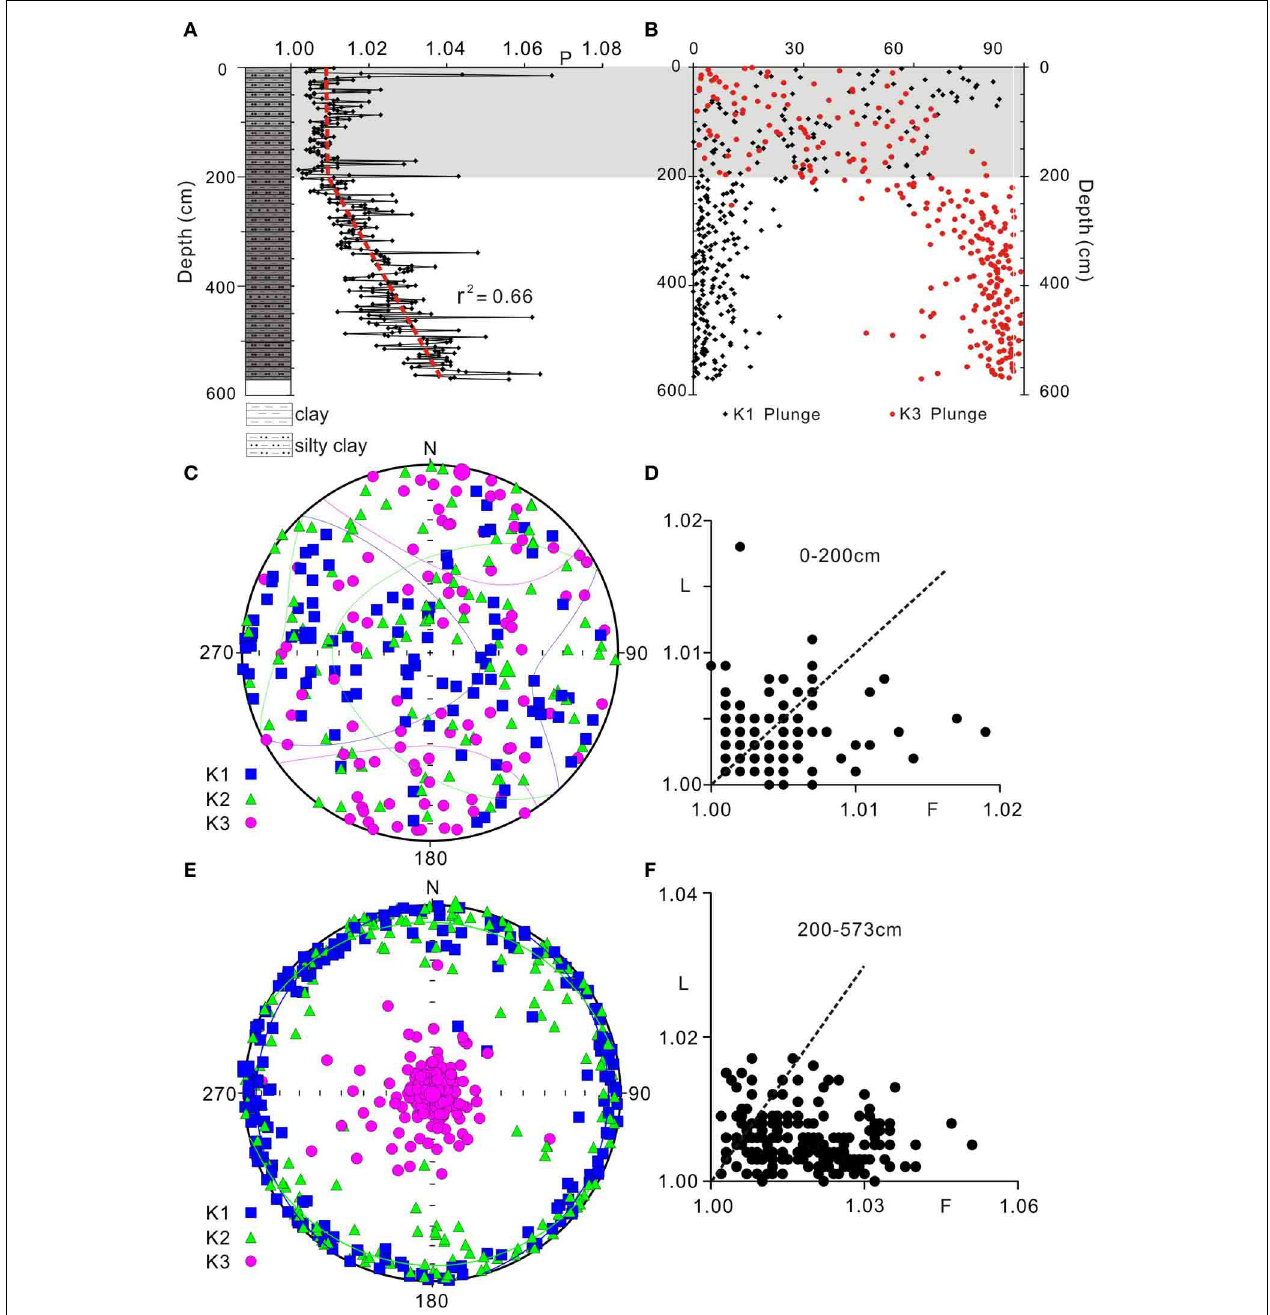
FIGURE 3 | Down-core changes in composition and AMS of Core GHE27L. The composition (A) and AMS characteristics (B–F) are similar to those of GHE24L ( Figure 2 ). The upper 2m display random AMS